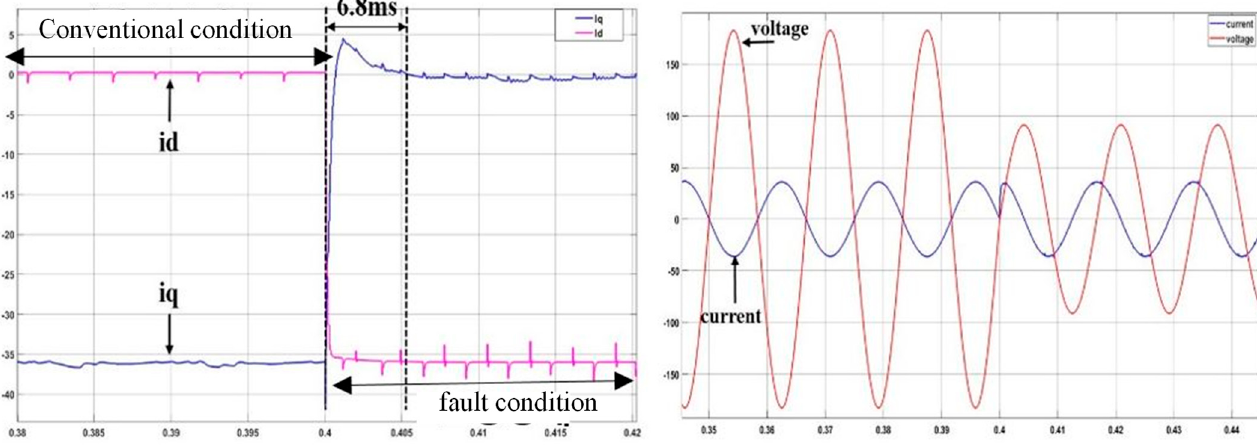
Figure 29. Response results of the proposed grid-connected devices depending on grid voltages.